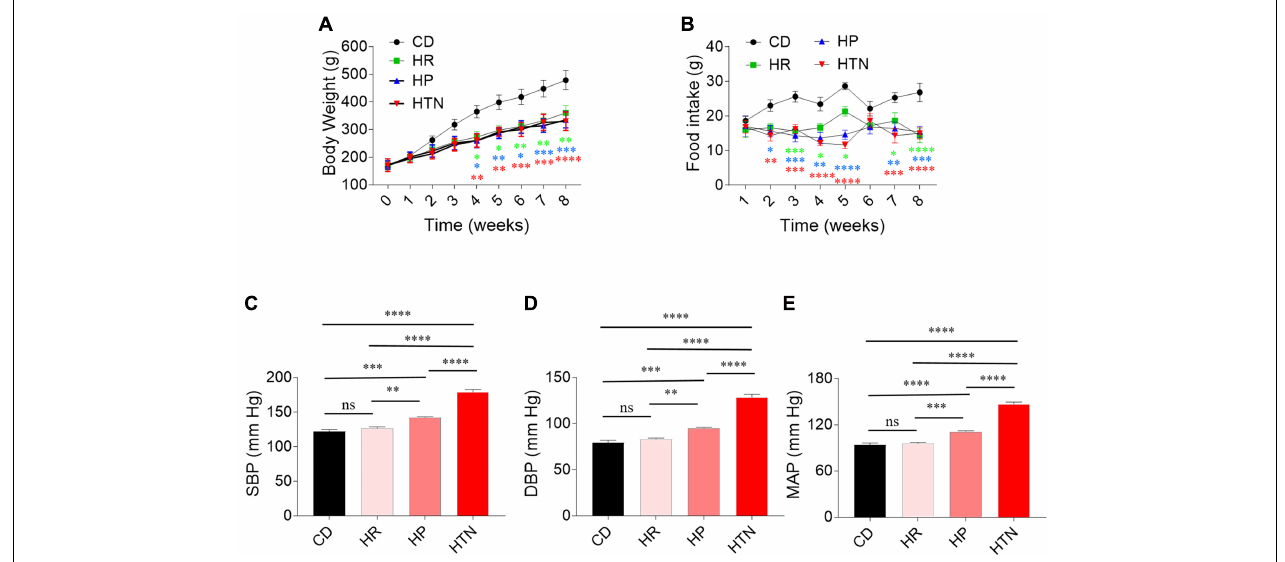
FIGURE 1 | Effects of high-salt diet (HSD) on body weight and blood pressure in rats. (A) The body weight in the HSD groups with hypertension-resistant (HR), hypertension-prone (HP), and hypertension (HTN) was less than that in the control diet (CD) group. (B–D) The SBP, DBP, and MAP in HTN were higher than that in CD, HR, and HP groups. The results are expressed as mean ± SEM; n = 10 in CD group, n = 14 in HR and HP group, and n = 17 in HTN group. ∗ p < 0.05, ∗∗ p < 0.01, ∗∗∗ p < 0.001, and ∗∗∗∗ p < 0.0001.